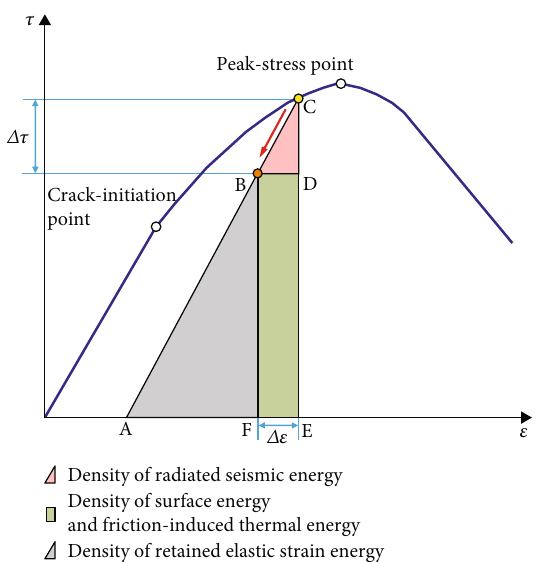
Figure 3: Conversion and distribution relationship of elastic strain energy density stored in a locked segment when a crack propagates (modi fi ed from Yang et al.